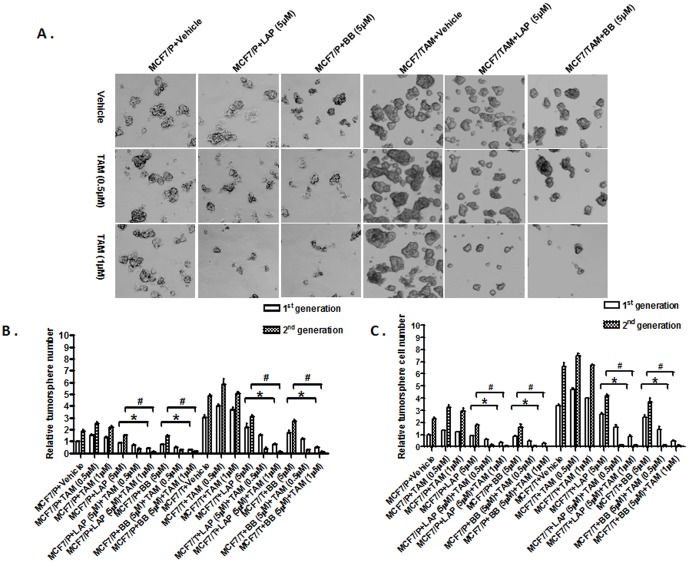
Disruption of the ER-α36-EGFR/HER2 positive regulatory loops sensitizes ER-positive breast cancer stem/progenitor cells to TAM.A. Tumorsphere formation assay was used to assess the effects of TAM alone or together with Lapatinib (LAP) or Broussoflavonol B (BB) on ER-positive breast cancer stem/progenitor cells derived from parental MCF7 (MCF7/P) and tamoxifen resistant MCF7 cells (MCF7/TAM). The representative results are shown. B. The numbers of tumorspheres formed by MCF7/P and MCF7/TAM cells in the presence or absence of LAP and BB for 1st and 2nd generations. C. The number of cells from dissociated tumorspheres formed by MCF7/P and MCF7/TAM cells in the presence or absence of LAP and BB for 1st and 2nd generations. The columns represent the means of three experiments; bars, SE. * & #, P<0.05 for MCF/TAM cells treated with vehicle vs cells treated with tamoxifen and LAP or BB, respectively.